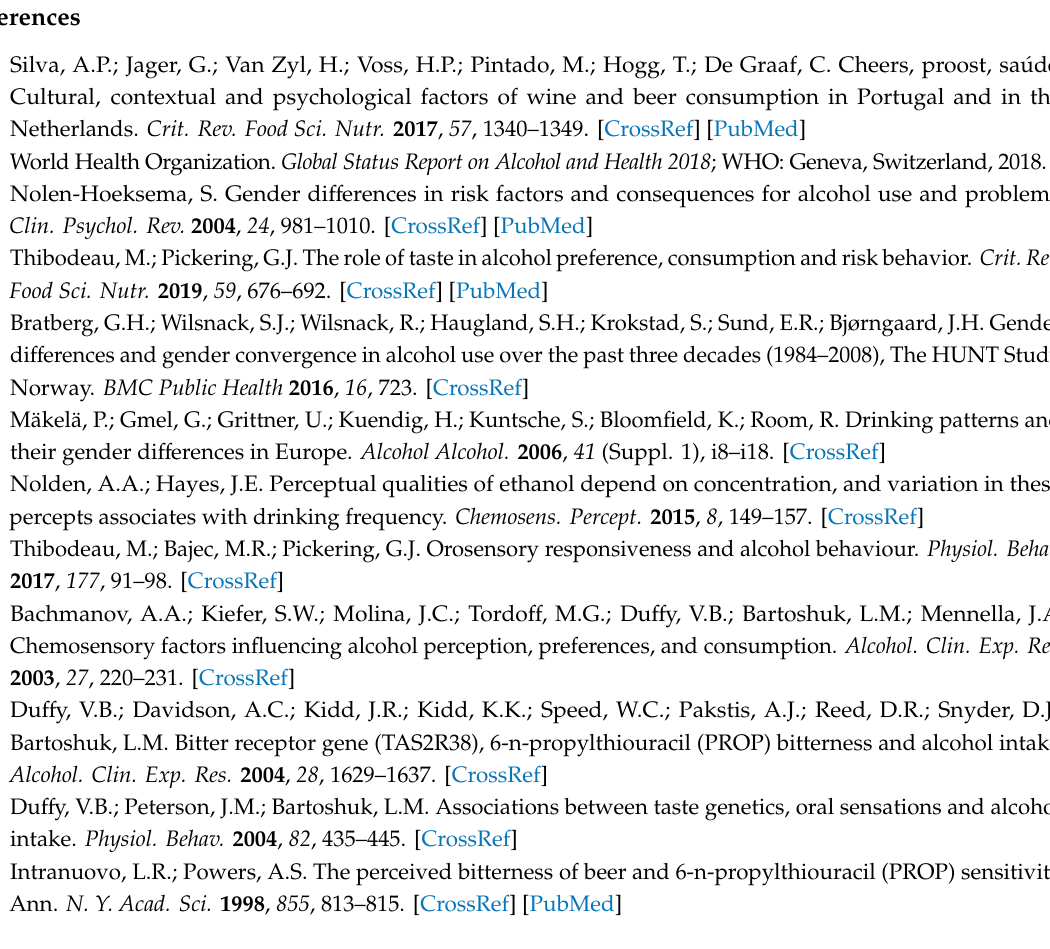
Figure S1: Mean liking scores for spirits, beers / wine and cocktails provided by the three consumers clusters (Spirit lovers, Beer / Wine lovers and Mild-drink lovers) by